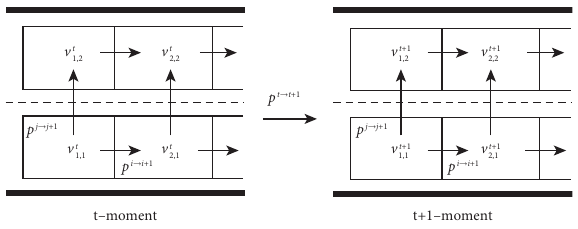
Figure 2: Te conduction process of the state between diferent grids.